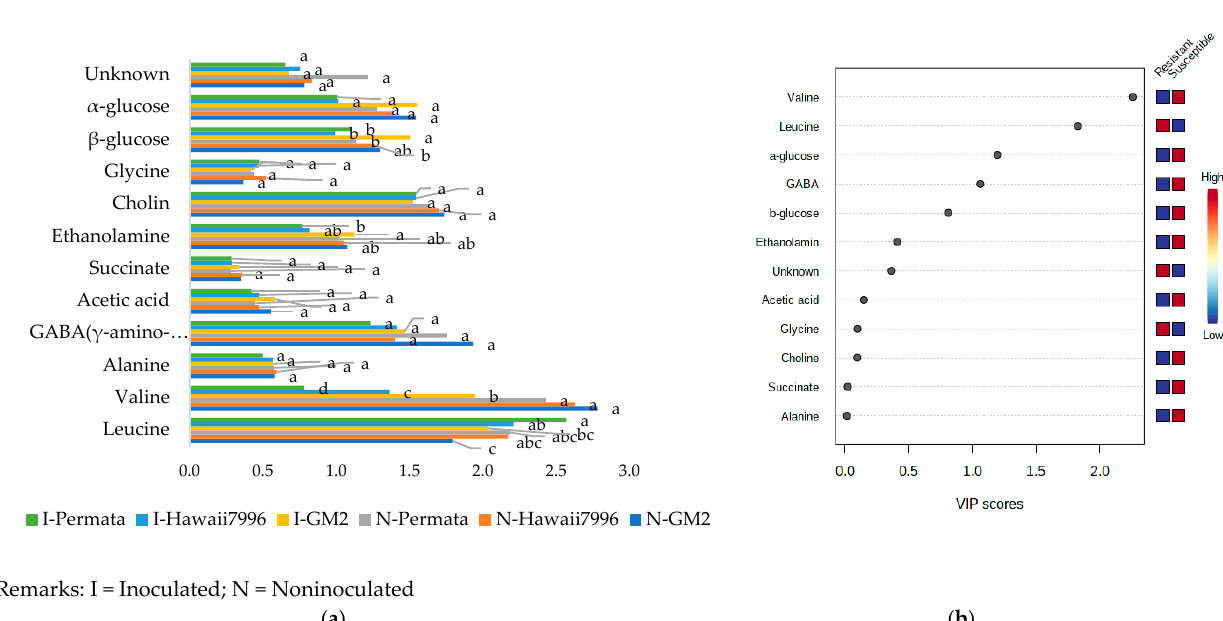
Figure 3. The concentration of peak assignment of tomato metabolites ( a ) and Variable Importance in Projection (VIP) of defined metabolites ( b ). Bars with the same letter in each group were not significantly different at p = 0.05 based on Tukey’s HSD tests.